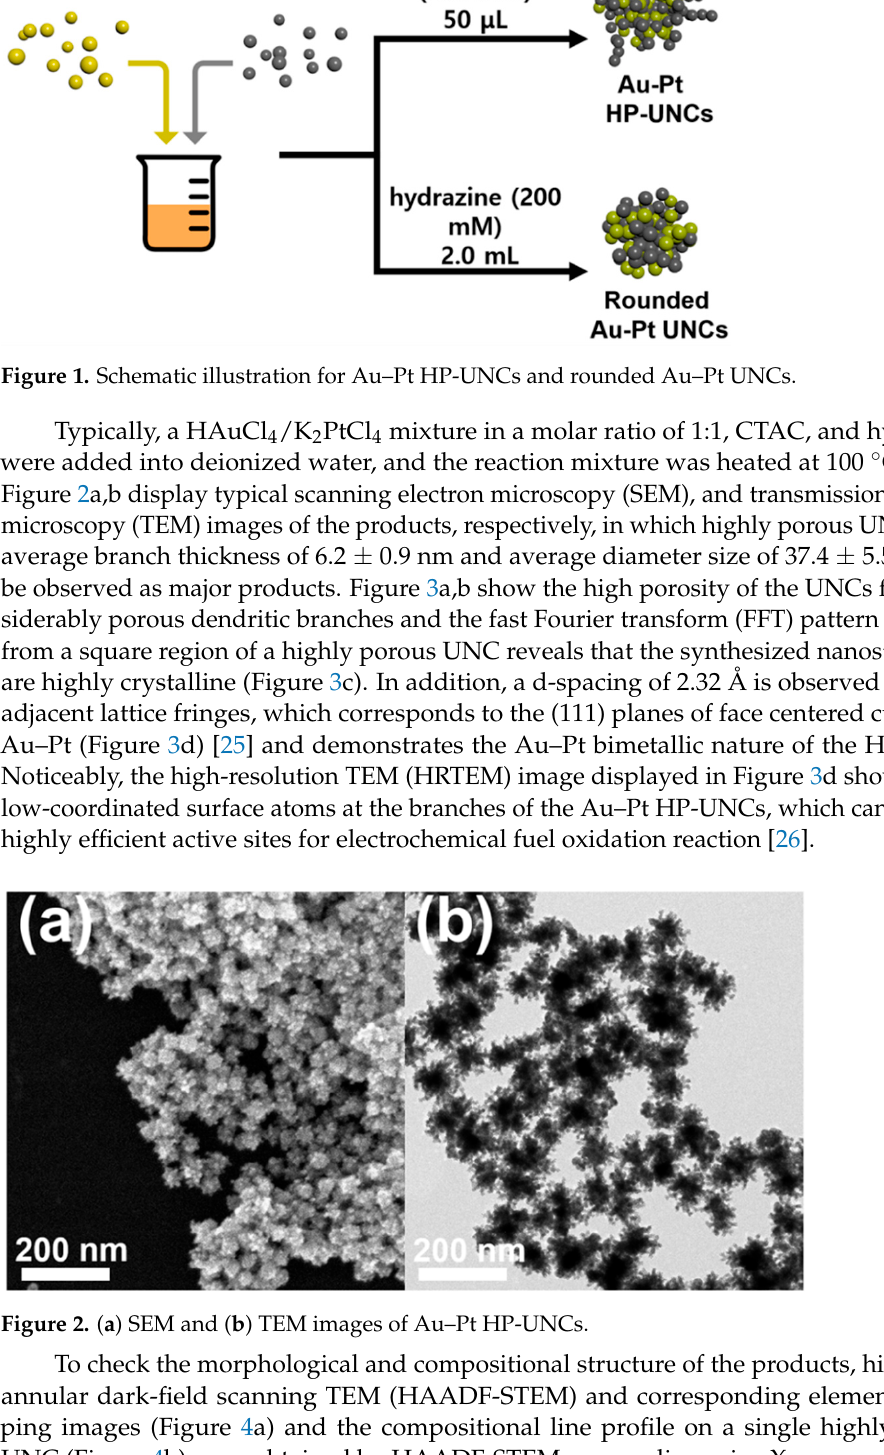
Figure 3. TEM images of; ( a ) an Au–Pt HP-UNC; and ( b ) branch of an Au–Pt HP-UNC. ( c ) FFT pattern obtained from yellow square in ( b ). ( d ) HR-TEM image in the branch of an Au–Pt HP- UNC. Figure 4. ( a ) HAADF-STEM, ( b ) cross-sectional compositional line profiles, and ( c – e ) HAADF- STEM-EDS elemental mapping images of an Au–Pt HP-UNC.